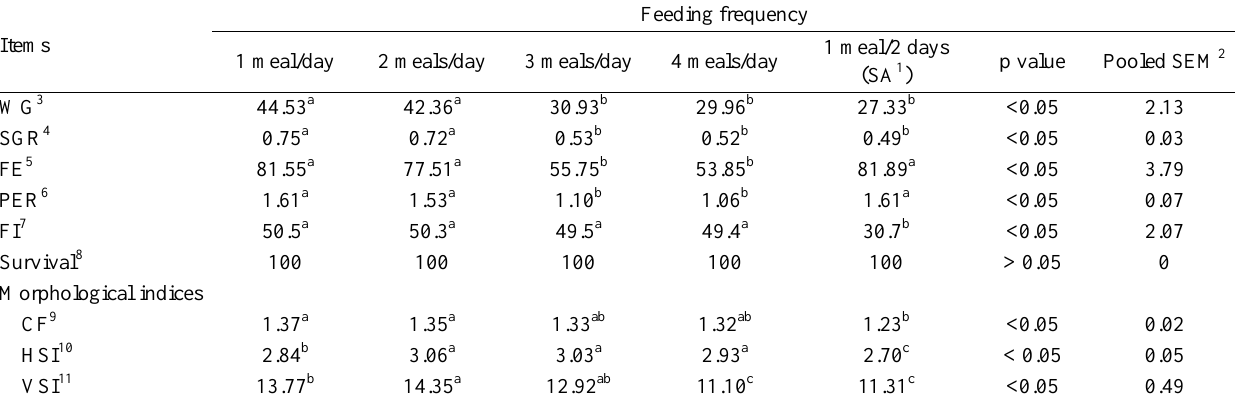
Feeding frequency